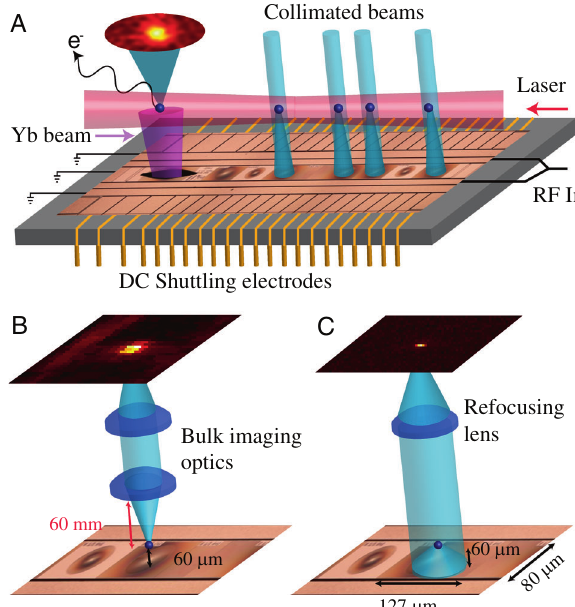
Fig. 1 a Schematic of the surface ion trap modi fi ed with an array of integrated monolithic diffractive mirrors. Neutral Yb from a thermal beam ( purple , left ) is photo-ionized in a loading zone, laser cooled, and the 174 Yb + ion ( blue dots ) is shuttled to one of the collimator sites by modulating the DC electrode array. Illustrated laser beam ( pink ) orientation is for clarity, actual is coplanar to chip surface and 45° to the RF rails. b Conventional ion fl uorescence imaging using external bulk optics with 1% collection ef fi ciency. c Diffractive mirror imaging with 5.8(8)% collection ef fi ciency of the π transition fl uorescence